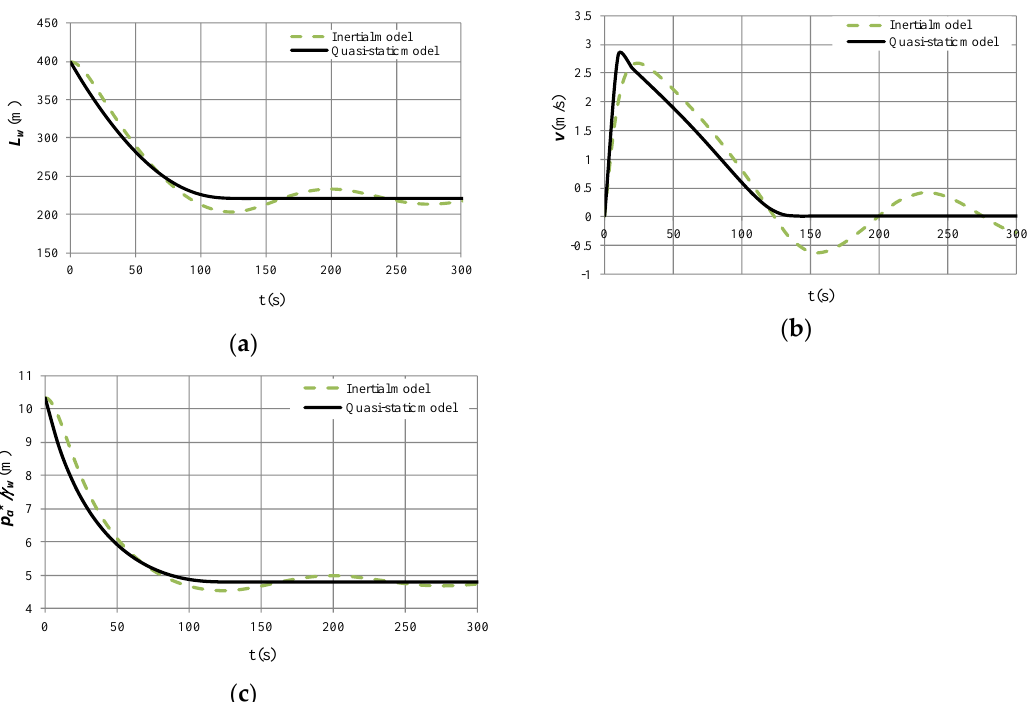
Figure 7. Comparison between the internal and quasi-static models for a draining process: ( a ) Water column evolution; ( b ) Behaviour of water velocity; ( c ) Air pocket pressure oscillation.